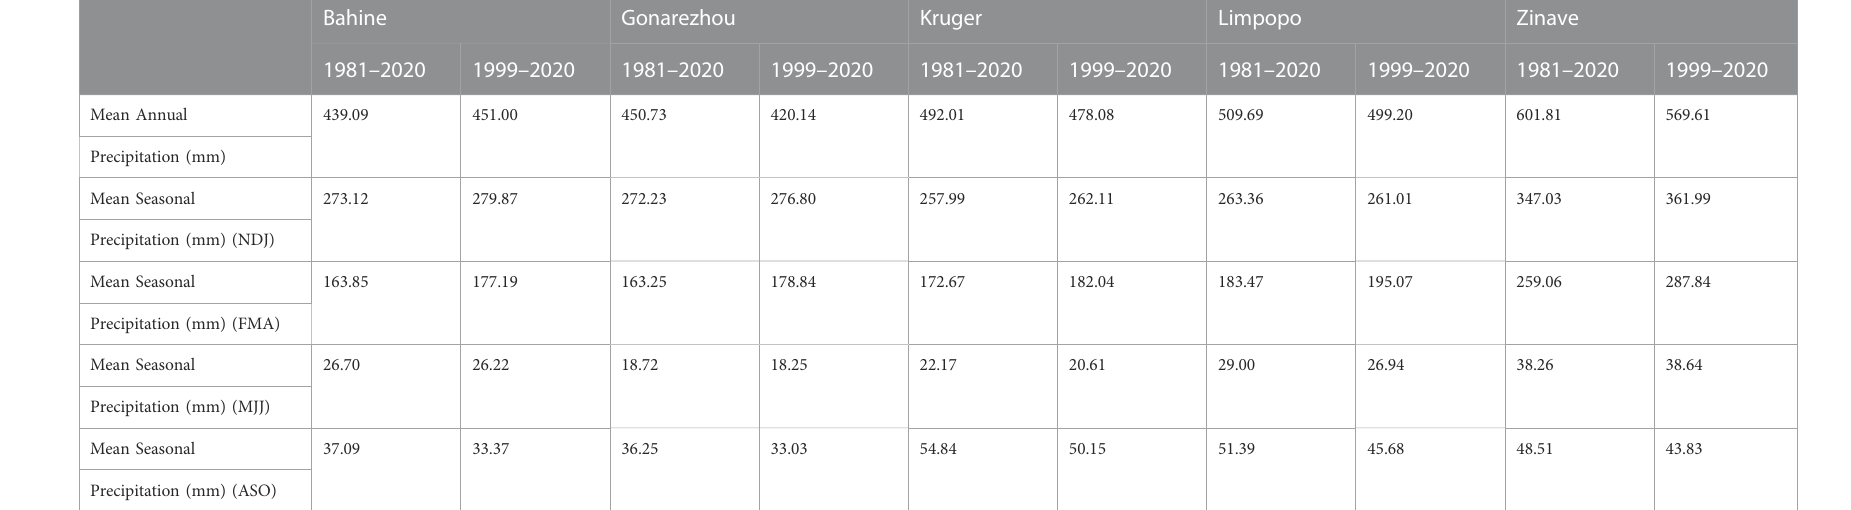
TABLE 2 Climatic conditions in national parks, including mean values of precipitation from 1981 to 2020 by both the total year and by season (lagged 1 month from vegetation, NDJ, November, December, January; FMA, February, March, April; MJJ, May, June, July; ASO, August, September, October). Bahine Gonarezhou Kruger Limpopo